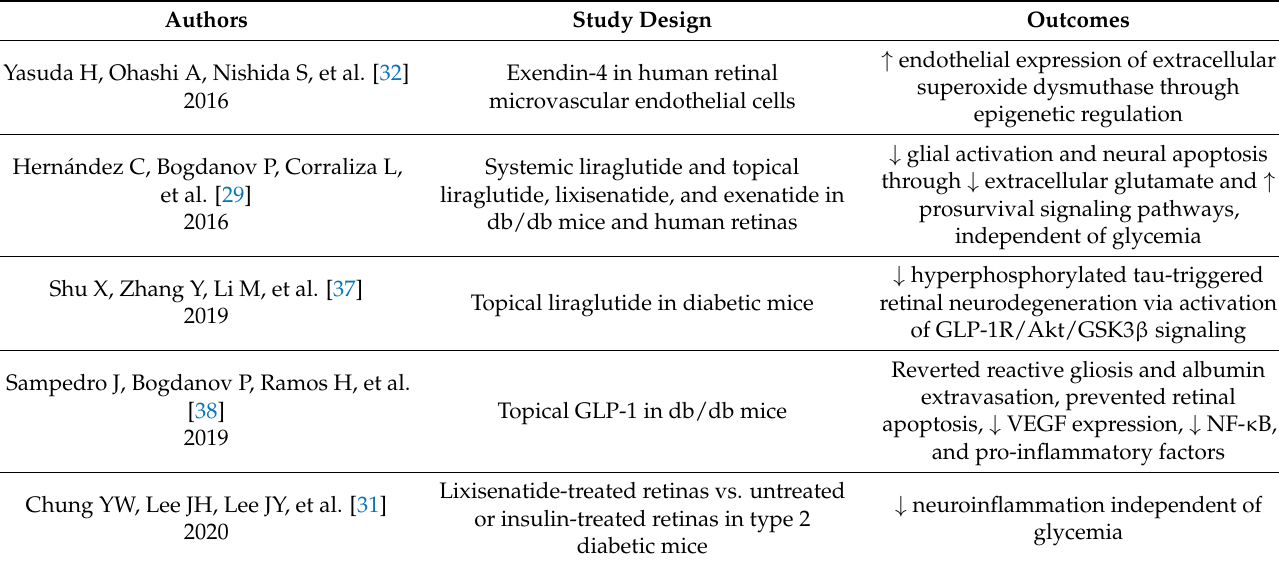
Table 1. Retinoprotective effects of GLP-1 RAs in pre-clinical